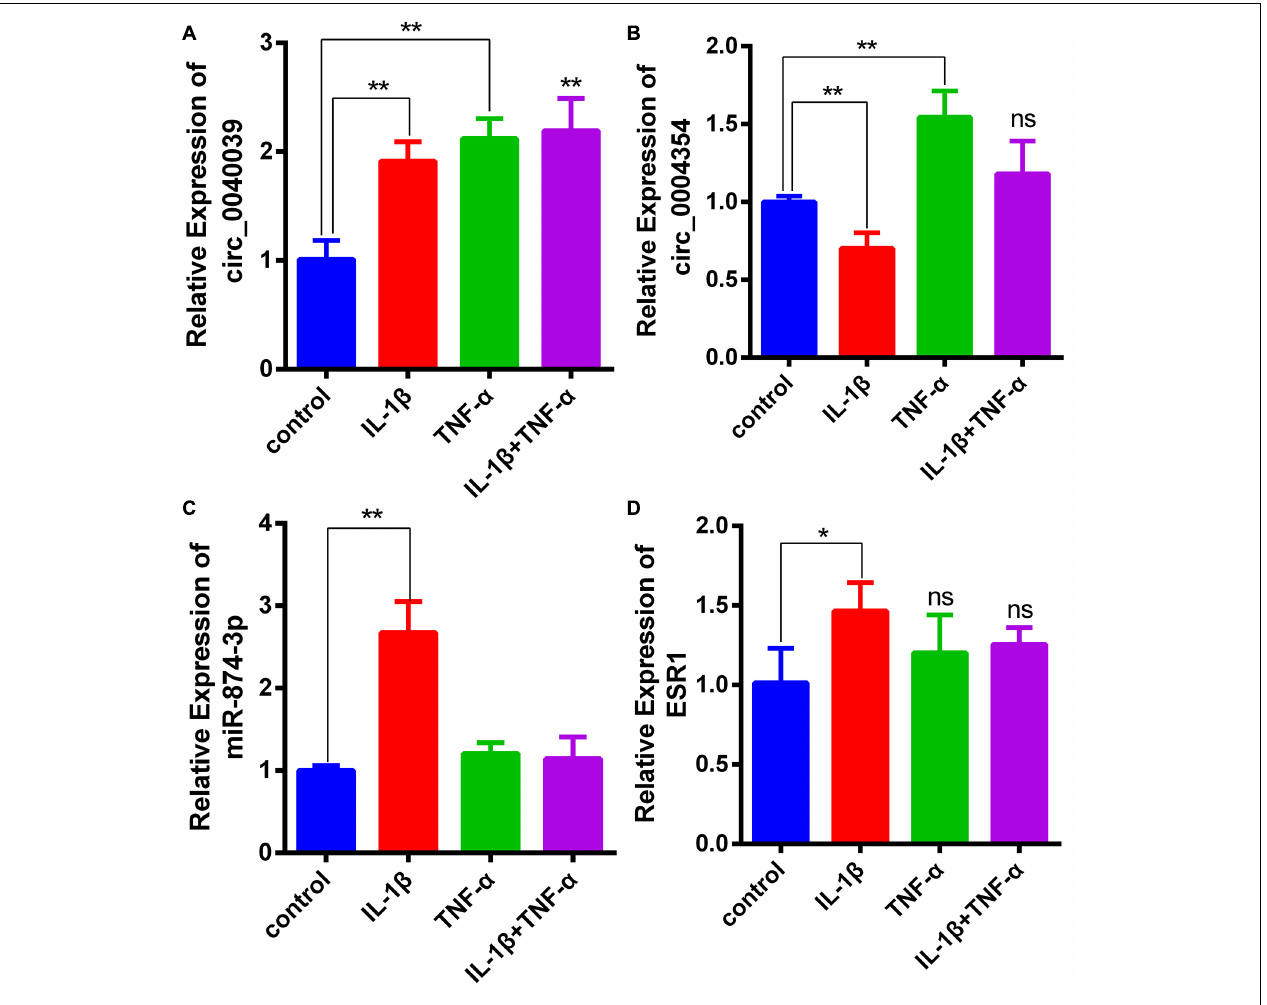
FIGURE 5 | Demonstration of the expression levels of circ_0040039, circ_0004354, miR-874-3p, and ESR1 in proinflammatory cytokine–treated NPCs. (A–D) Expression levels of circ_0040039, circ_0004354, miR-874-3p, and ESR1 in NPCs were detected using the qRT-PCR assay in response to different proinflammatory cytokine treatments. Among these, circ_0040039, miR-874-3p, and ESR1 expression levels increased in IL-1 β –treated NPCs. Data are represented as the mean ± SD. * P < 0.05, ** P < 0.01.